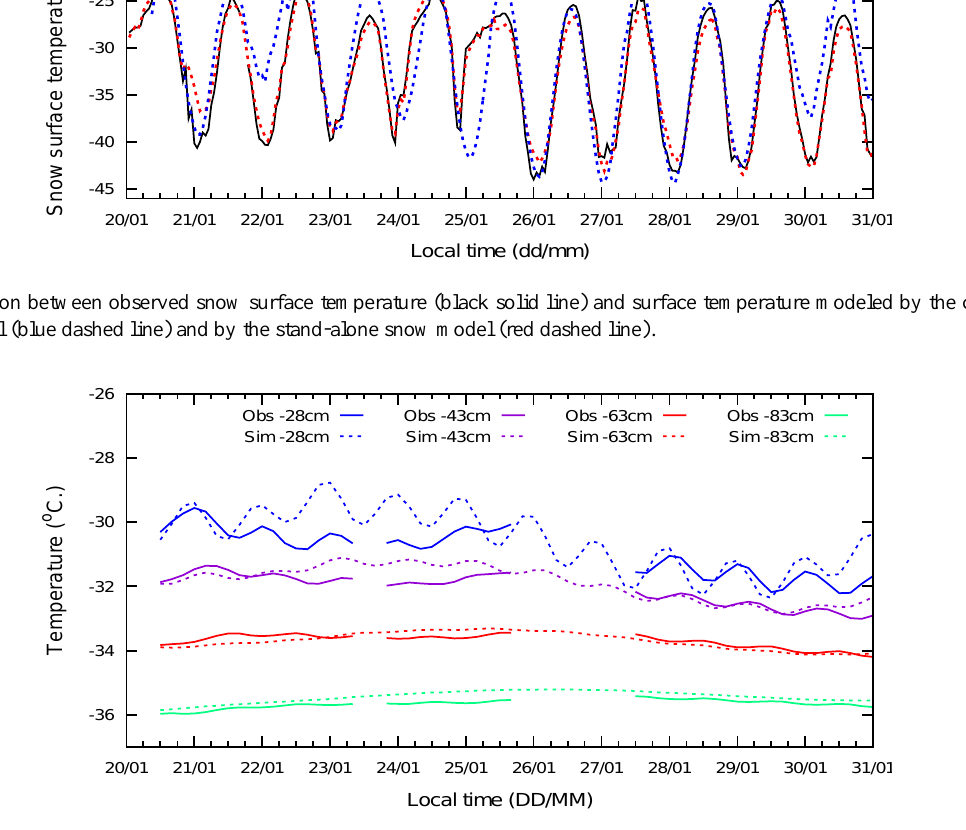
Fig. 9. Comparison between observations (solid line) and coupled simulations (dashed line) of snow temperature at different depths in the top 1 meter of the